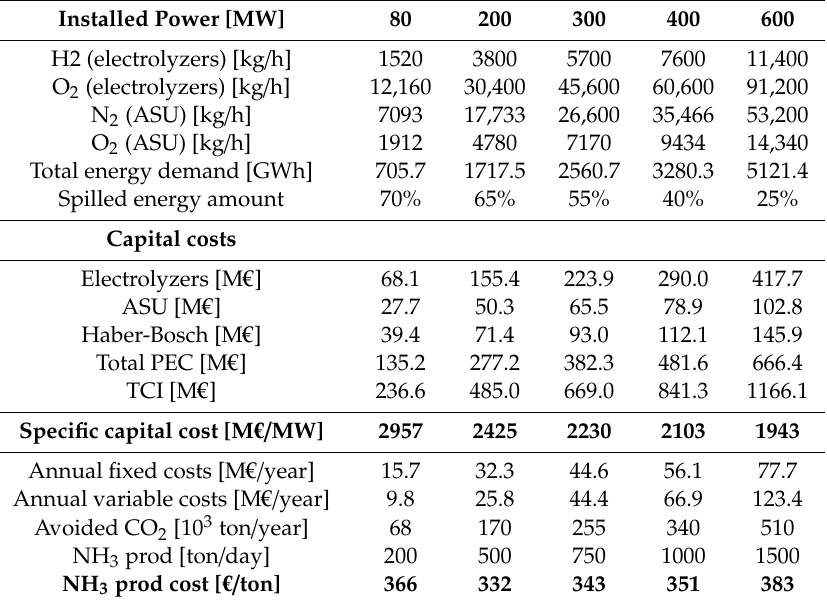
Table 4. Ammonia synthesis costs for di ff erent